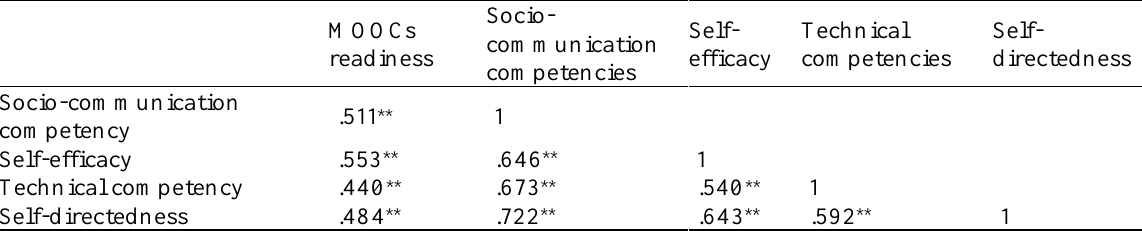
Correlation Analysis – Pearson Correlation Matrix